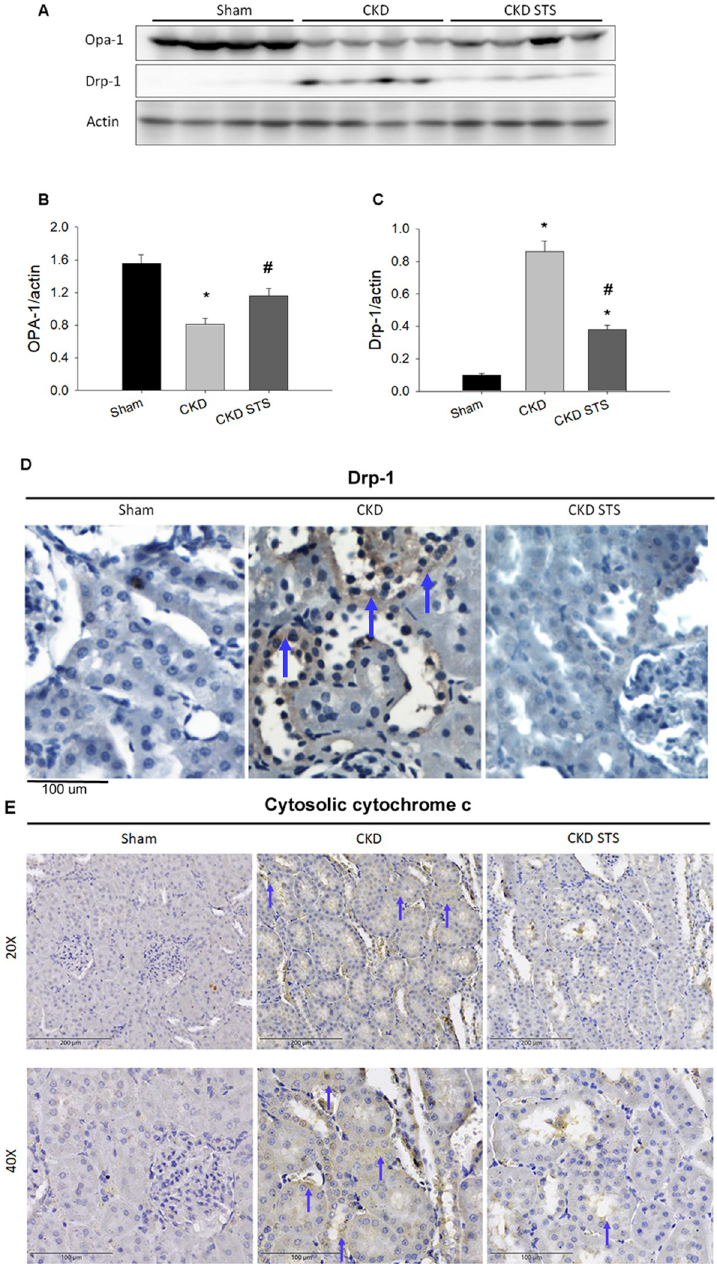
Fig 9. Effect of STS on CKD induced mitochondrial fission and fusion and mitochondrial injury. Western blot of renal OPA-1 and Drp-1 expression in CKD kidneys (A). The statistical data of densitometry is indicated in B and C, respectively. Immunohistochemistry of mitochondrial fission Drp-1 indicated by blue arrows is indicated in D. Mitochondrial injury indicated by the appearance of cytosolic cytochrome C by blue arrows is demonstrated in E. Data are expressed as mean ± SEM (n = 3). � P < 0.05 vs. Sham. # P < 0.05 vs.